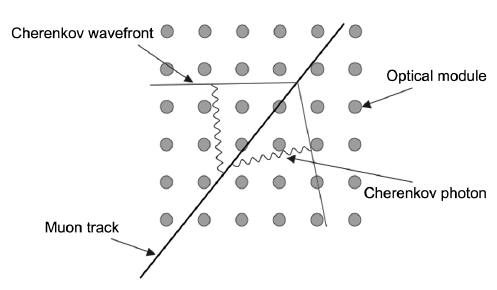
Fig. 1. Detection principle of an underwater neutri- no telescope. Astrophysical neutrinos that interact close to the detector generate secondary muons that can be detected by means of their Cherenkov light emission. The measure of arrival times of the Che- renkov light on the optical modules allows to recon- struct the muon